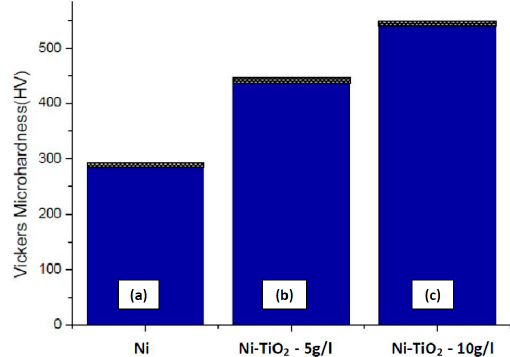
Figure 9. Vickers microhardness of the electrodeposited Ni on copper ( a ) without and with the addition of TiO 2 , ( b ) 5 g/L of TiO 2 , ( c ) 10 g/L of TiO 2 . of TiO 2 , ( b ) 5 g / L of TiO 2 , ( c ) 10 g / L of TiO 2